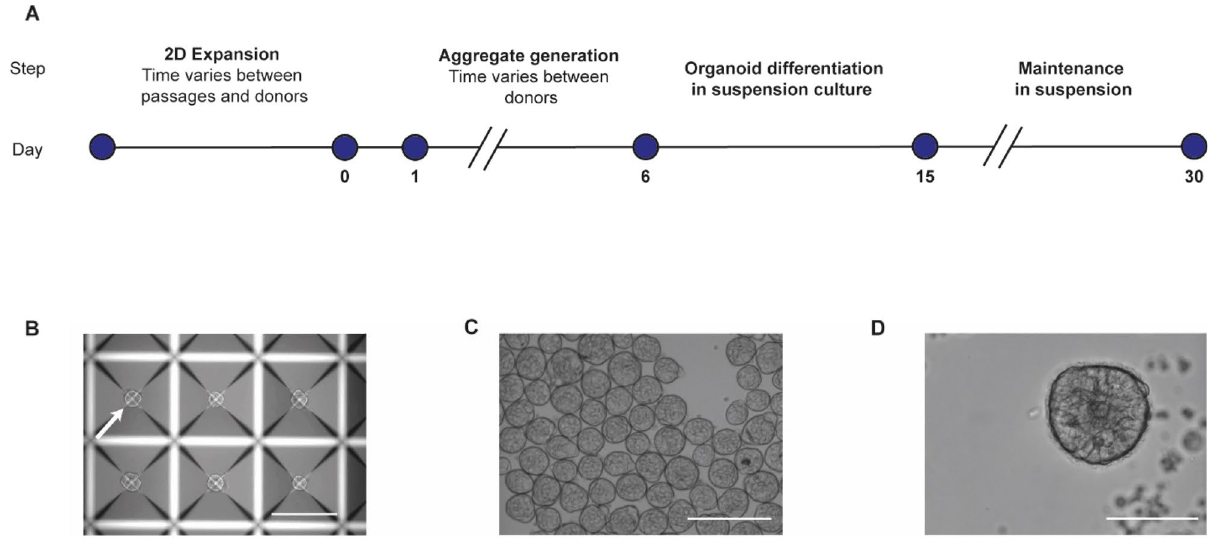
Figure 1. Generation of airway organoids with apical-out orientation from hBEC aggregates. ( A ) Workflow for the generation of apical-out organoids showing the time requirement for each step. ( B ) Representative brightfield image of aggregates generated by hBECs after 1 to 6 days of incubation in a microwell. Arrow points at a representative aggregate located in the centre of the microwell (scale bar 300 μm). ( C ) Representative brightfield image of aggregates after initiation of suspension culture (scale bar 200 μm). ( D ) Representative brightfield image of terminally differentiated Ap-O AO at day 15. Cilia can be detected at the edge of the organoid (scale bar 100